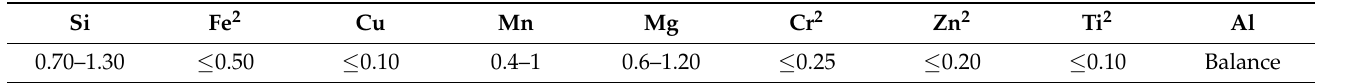
Table 1. Chemical composition of the investigated alloy (EN AW 6082